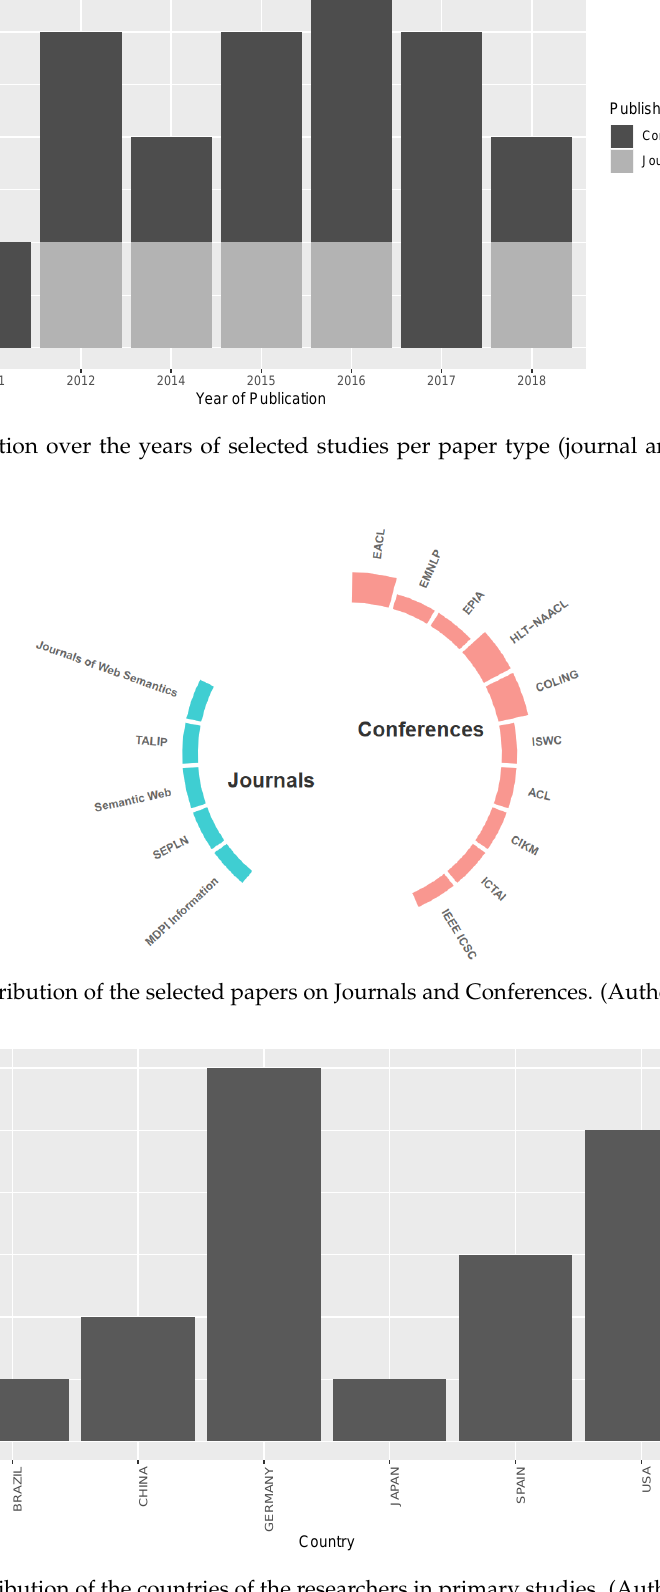
Figure 5. Distribution of the countries of the researchers in primary studies. (Authors’